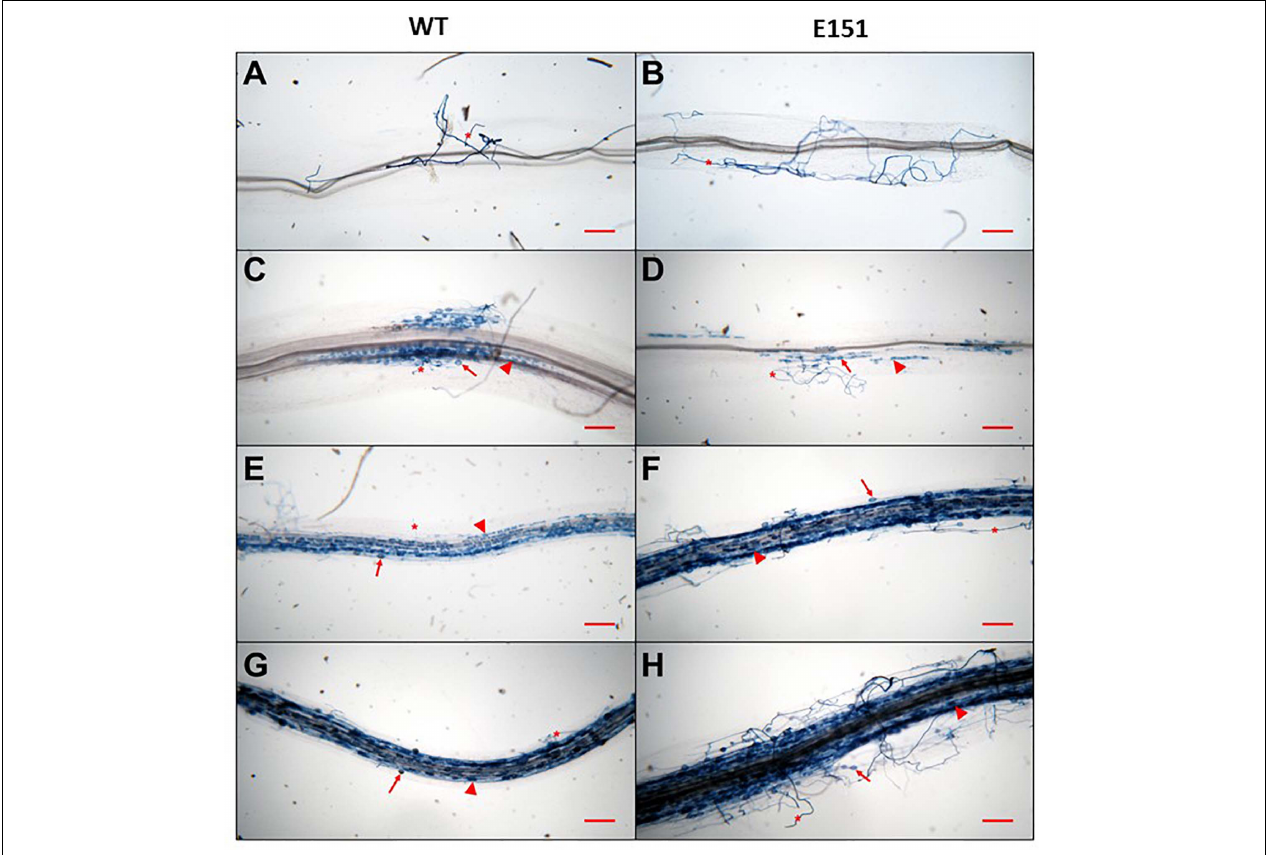
FIGURE 2 | Development of arbuscular mycorrhizae resulting from the association formed between Rhizophagus irregularis and pea plants. WT (A,C,E,G) and the mutant E151 (B,D,F,H) were compared at different time points. At 10 DAI (A,B) , extra-radicular hyphae (asterisks) were seen on the root surface of both pea lines. Root entry and subsequent internal colonization of the fungus were first observed at 15 DAI (C,D) , at which point fungal colonization in WT appears to be more extensive than in E151. At 15 DAI, arbuscules (arrowheads) and vesicles (arrows) were already formed. At 20 DAI (E,F) and 25 DAI (G,H) , E151 roots exhibited many more fungal structures than WT roots. Bars = 250 µ